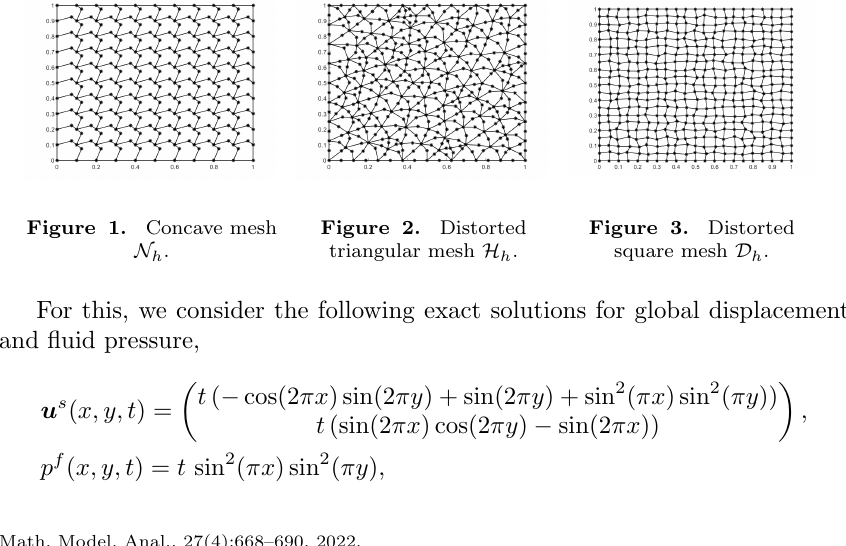
Figure 1. Concave mesh N h .